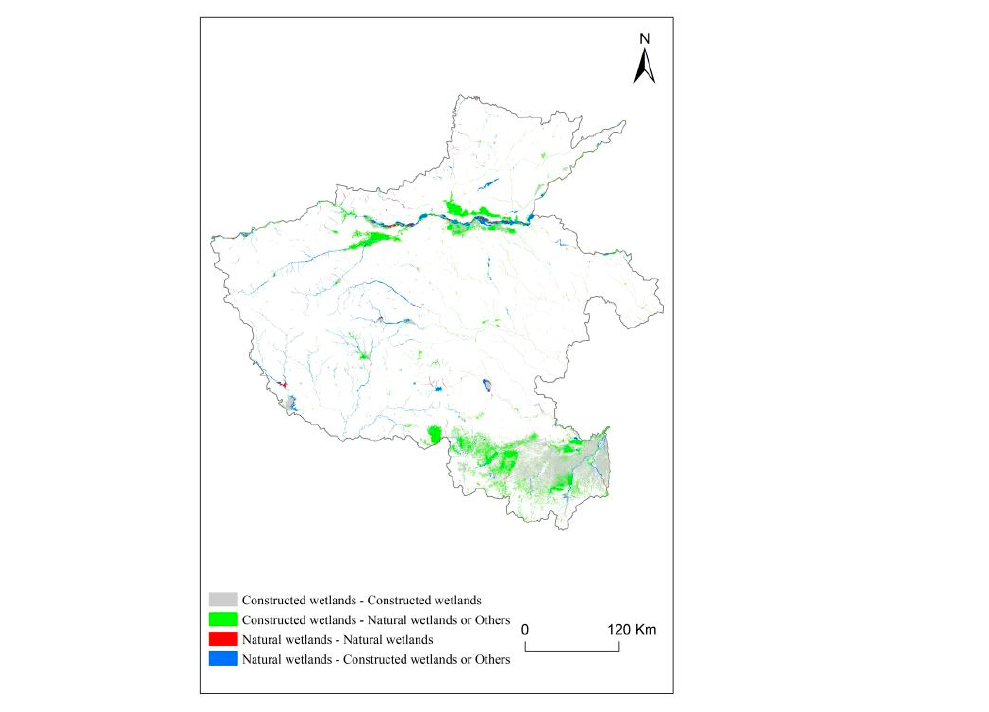
Figure 7. Transformation between constructed wetlands and natural wetlands from 1980–2015. Table 4. Transfer matrix of wetland changes from 1980 to 2015. km 2 .